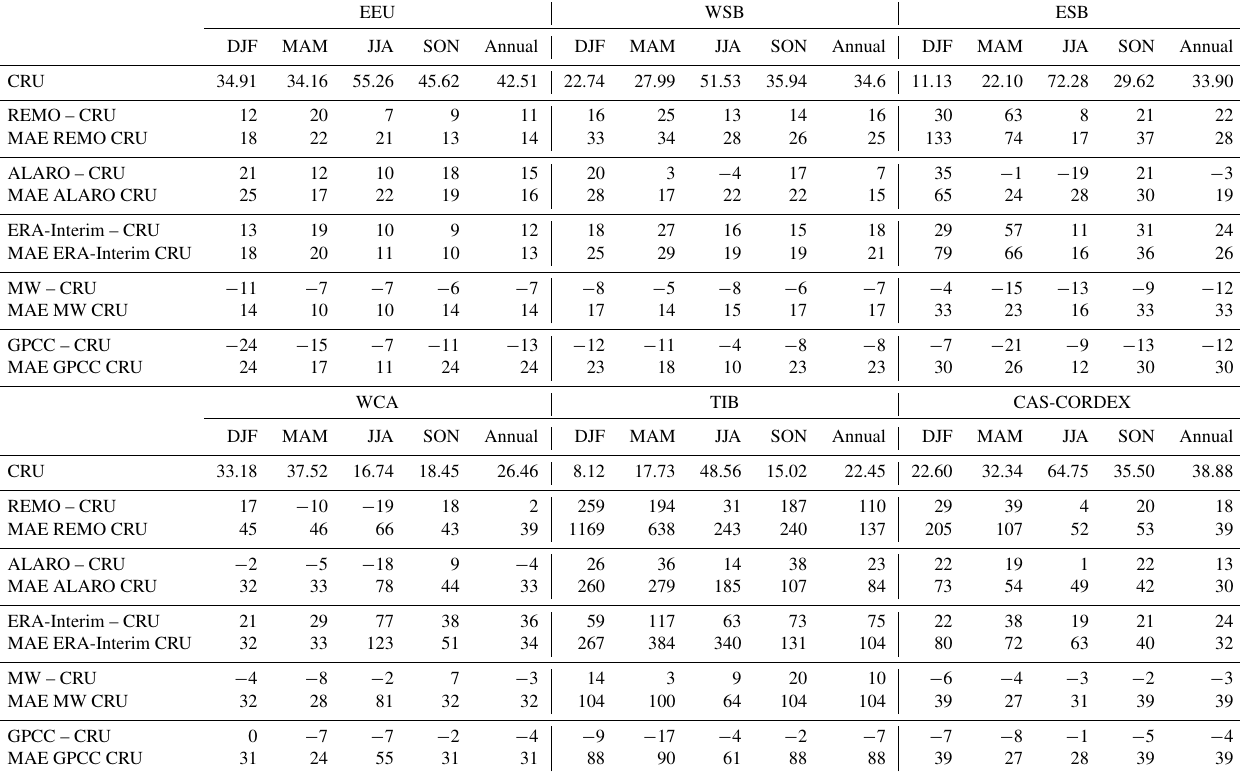
Table 5. Climatological mean CRU precipitation (mm per month) for the 1980–2017 period over the CAS-CORDEX domain and subdomain, with relative biases (%) and MAE (%) against CRU for the RCMs (REMO and ALARO-0) and the other reference datasets (ERA-Interim, MW, and